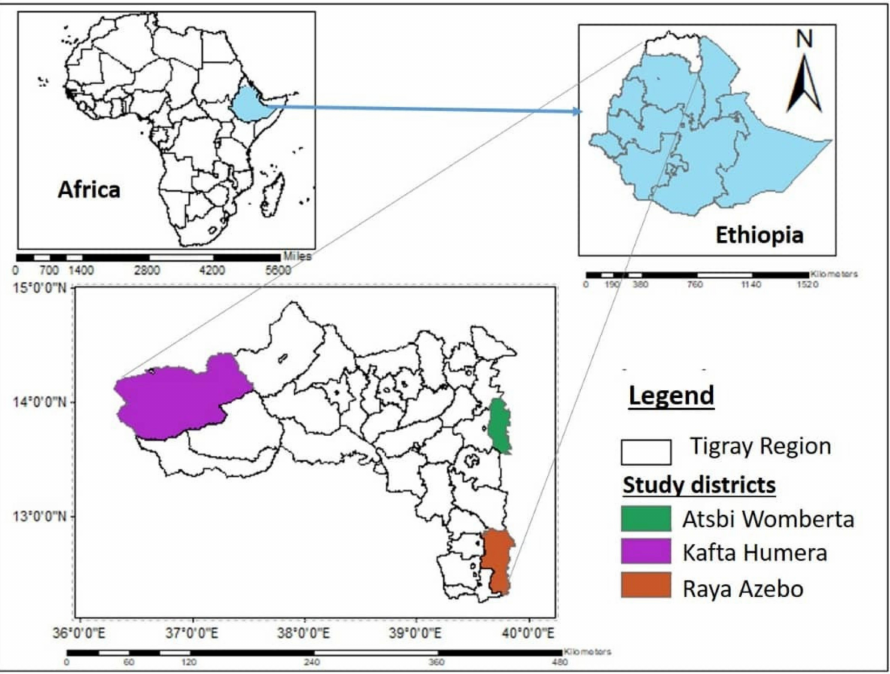
Figure 1. Location of the study area in the different agro-semiecologies of Tigray Region,